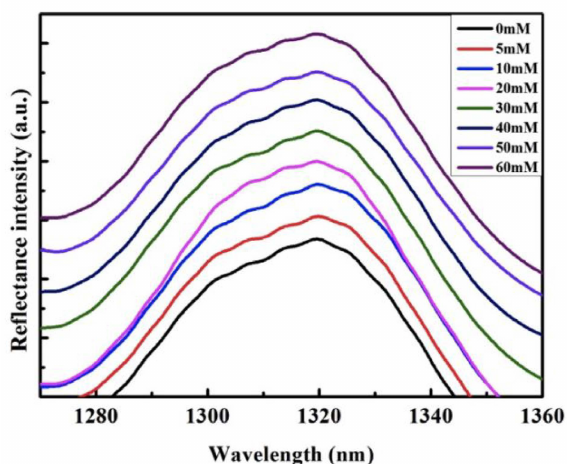
Figure 13. Spectra of glucose concentrations from 0 to 60 mM